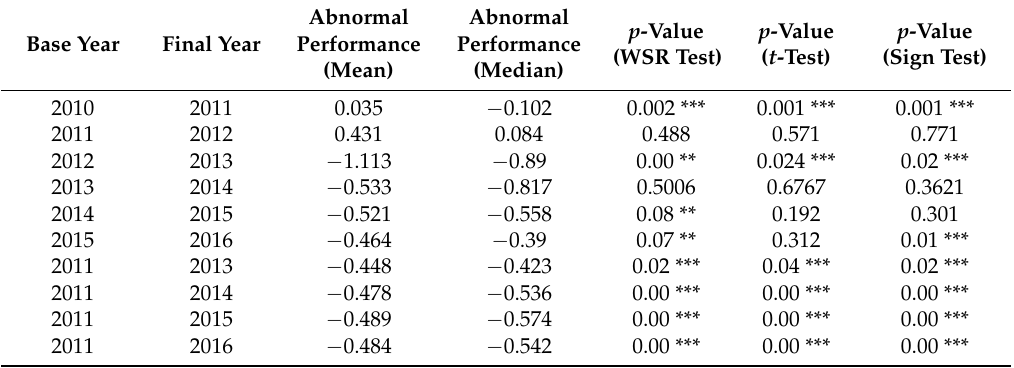
Table 3. Alternative test: Abnormal performance in market valuation, one-to-one matched by ROA and industry.